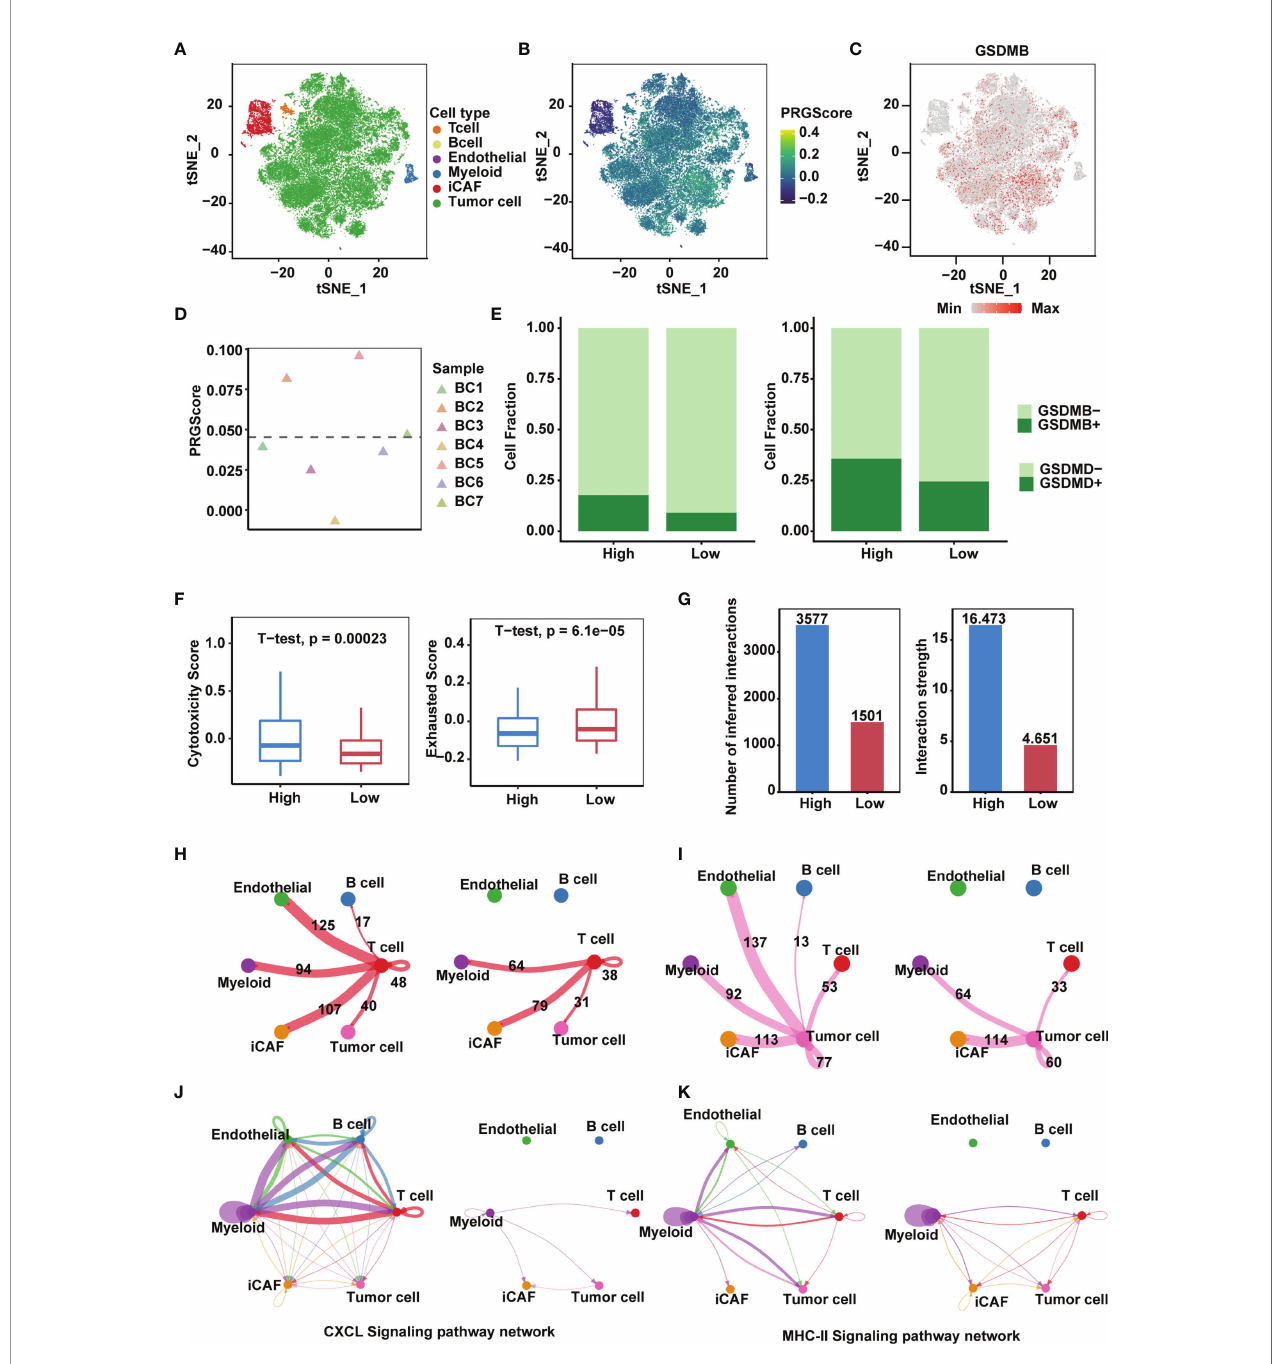
FIGURE 6 | High PRGScore implies an immune-active tumor microenvironment in the single cell cohort. (A) t-SNE plot showing the composition of 6 main subtypes derived from bladder cancer samples. (B) The dynamics of PRGScore in 6 main cell types are represented in the t-SNE plot. (C) t-SNE plot showing the expression level of GSDMB for all the cell types. (D) Distribution in the PRGScore of seven bladder cancer samples (divided into 2 patterns). (E) The proportion of GSDMB + tumor cells (left) and GSDMD + tumor cells (right) in the high or low PRGScore group. (F) Differences in cytotoxic score (left) and exhausted score (right) of T cells between two pyroptosis groups. (G) Differences in number of inferred interactions (left) and interaction strength (right) of all cells between two pyroptosis groups. (H) Circos plots displaying putative ligand-receptor interactions between T cells and other cell clusters from high-PRGScore (left) and low-PRGScore (right) group. The brand links pairs of interacting cell types, and corresponding number of events were labeled in the graph. (I) Circos plots displaying putative ligand-receptor interactions between Tumor cells and other cell clusters from high-PRGScore (left) and low-PRGScore (right) group. The brand links pairs of interacting cell types, and corresponding number of events were labeled in the graph. (J) Circos plots showing the CXCL signaling pathways between high-PRGScore (left) and low- PRGScore (right) group. (K) Circos plots showing the MHC-II signaling pathways between high-PRGScore (left) and low-PRGScore (right)